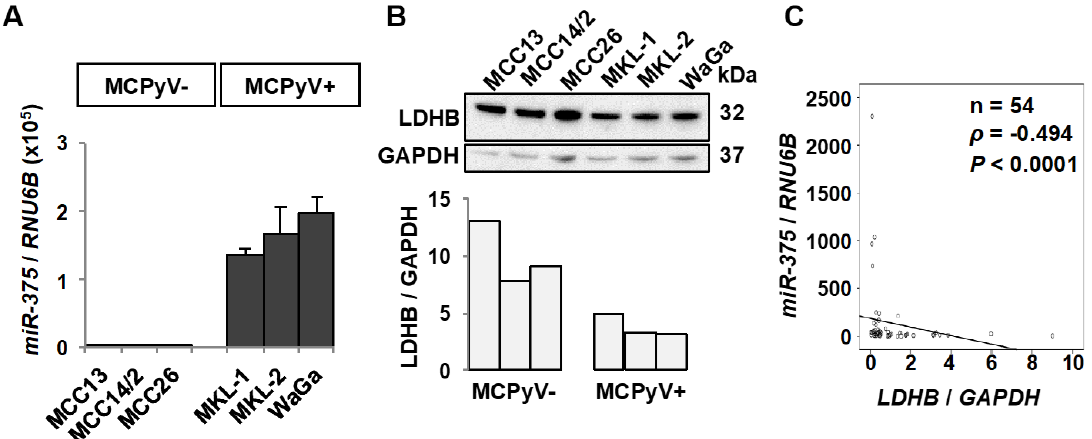
Figure 1. LDHB is inversely correlated with miR-375 in MCC tumors and cell lines. ( A ) miR-375 levels were quantified in six MCC cell lines using RT-qPCR. RNU6B was used for normalization purpose. Error bars represent SEM of four independent RNA isolations and RT-qPCR measurements. ( B ) Western blot analysis of LDHB protein expression in MCC cell lines. Western blot images of the LDHB and GAPDH levels are shown in the upper panel, and the quantifications of the LDHB levels are presented in the graph. The LDHB levels were normalized to GAPDH. ( C ) miR-375 and LDHB mRNA levels were measured in 54 MCC tumor samples using RT-qPCR. The expression correlation between miR-375 and LDHB mRNA was assessed by Spearman’s rank order correlation.